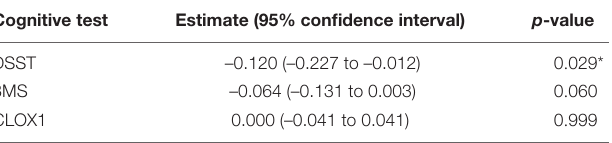
TABLE 5 | Multivariable linear mixed models. Cognitive test Estimate (95% confidence